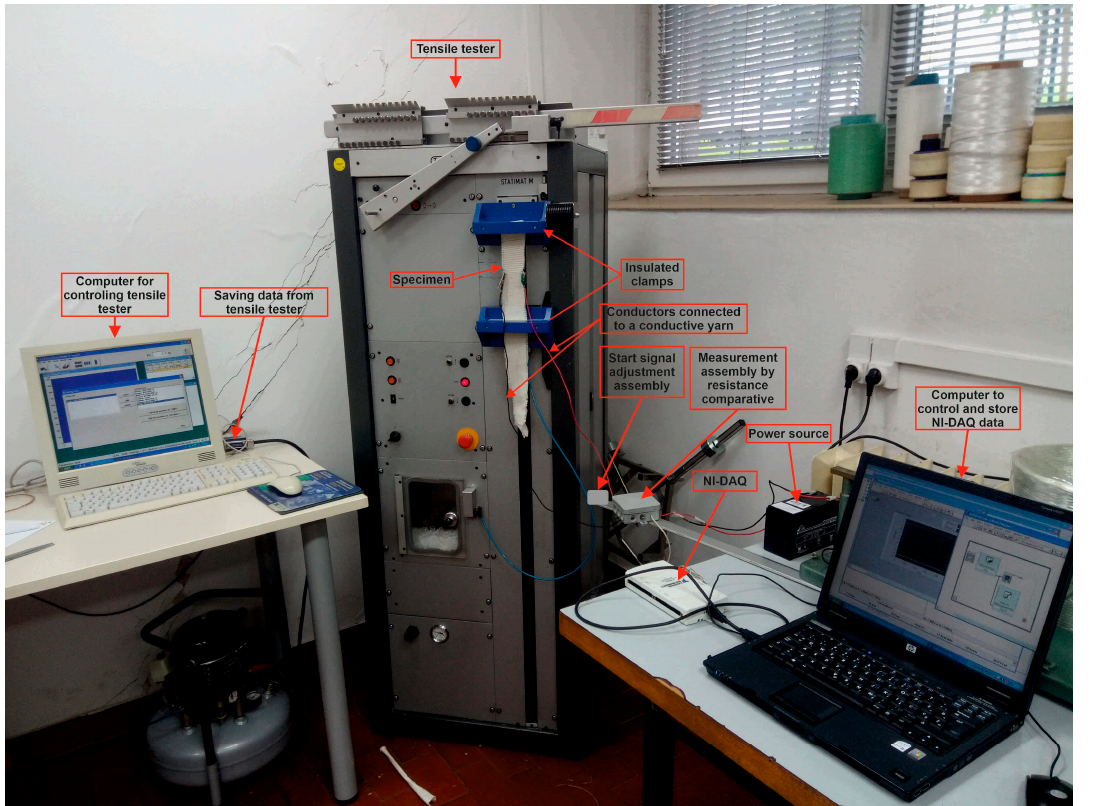
Figure 5. Photo of the measuring system.